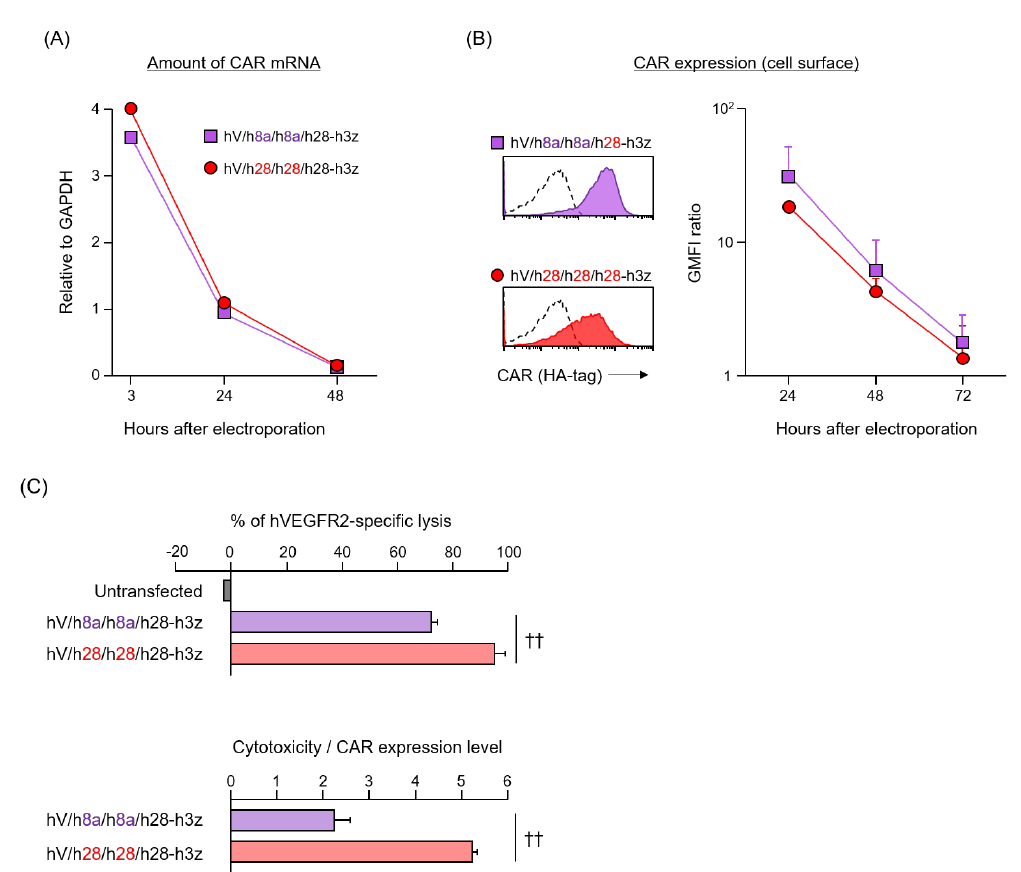
Figure 4. Expression and function of hinge / transmembrane domains (HD / TMD)-modified CARs in human T cells introduced CAR mRNA by electroporation. ( A ) CAR mRNAs were analyzed by reverse transcription and quantitative polymerase chain reaction, and their amount were calculated relative to GAPDH mRNA. ( B ) CAR expression on T cells were analyzed by flow cytometry using anti-HA-tag mAbs (solid color histograms) or isotype control antibody (dashed white histograms). Each CAR expression level was calculated from the ratio of geometric mean fluorescence intensity (GMFI) when stained with the anti-HA-tag mAb to GMFI when stained with the isotype antibody. ( C ) Top panel, cytotoxic activity of human CAR-T cells cultured for 24 h after electroporation against hVEGFR2 + L1.2 cells at E / T ratio = 10; lower panel, cytotoxicity per CAR expression level. The data were obtained from three independent tests. Statistical analysis was performed using Student’s t -test; †† p < 0.01.